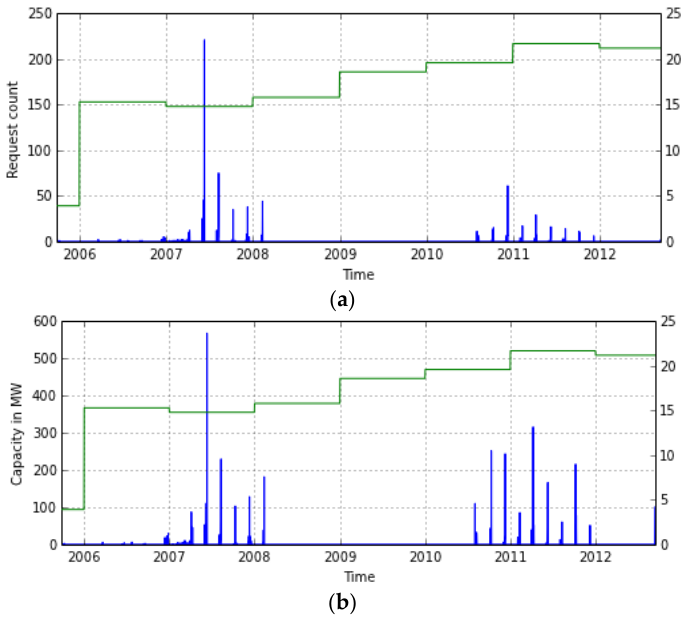
Figure 4. Evolution of demand and the PI for PV investments of capacity equal to or greater than 1 MW. ( a ) Number of operation license requests for 1 MW and greater PV RES ‐ E during September 2005 to September 2012; and ( b ) capacity that corresponds to the operation license requests for 1 MW and greater PV RES ‐ E during September 2005 to September 2012.